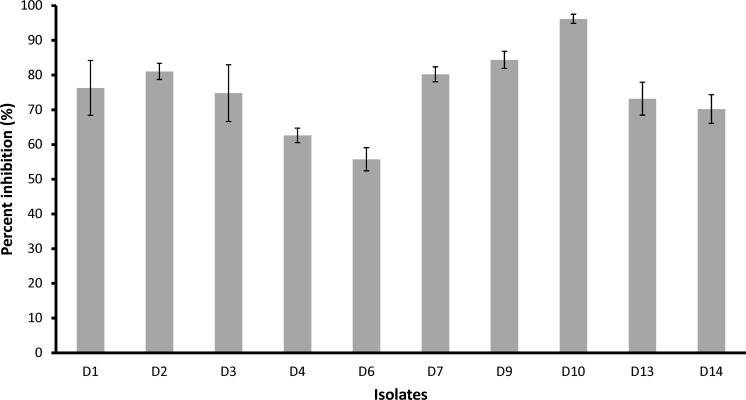
Inhibition of mycelial growth of ten L. maculans isolates by pterostilbene.Hyphal plugs were cultured for six days on half strength V8 agar amended with 50 μg/ml pterostilbene. Mycelial growth is expressed as the percentage (%) of growth in the treatment relative to the control. Vertical bars represent standard deviation. All values were statistically significant at p<0.01 in Student’s t-test with degrees of freedom = 4.